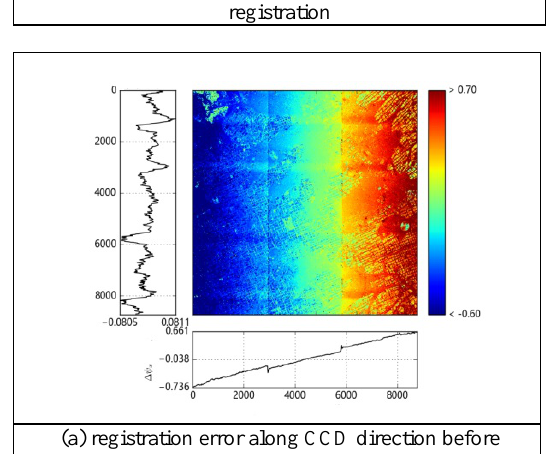
Fig2.The True color Comparison chart before and